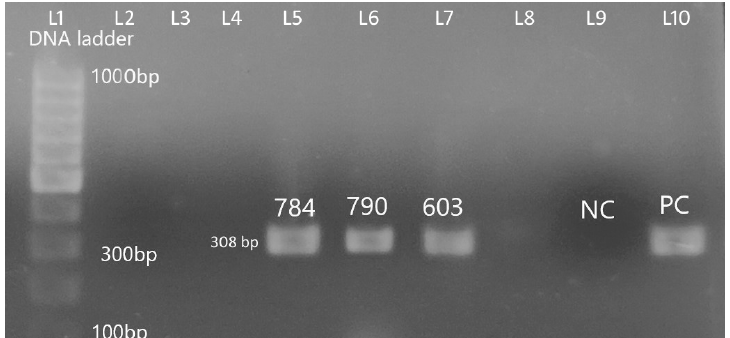
Figure 4. Amplification of plasmid-mediated mcr - 1 gene from different E. coli isolates with positive and negative controls (Lane 1, marker (GeneRuler 100 bp DNA Ladder, Thermo Fisher Scientific), Lane 2–Lane 4, no amplifications; Lane 5–Lane 7, positive amplification; Lane 8, no amplification; Lane 9, negative control; Lane 10, positive